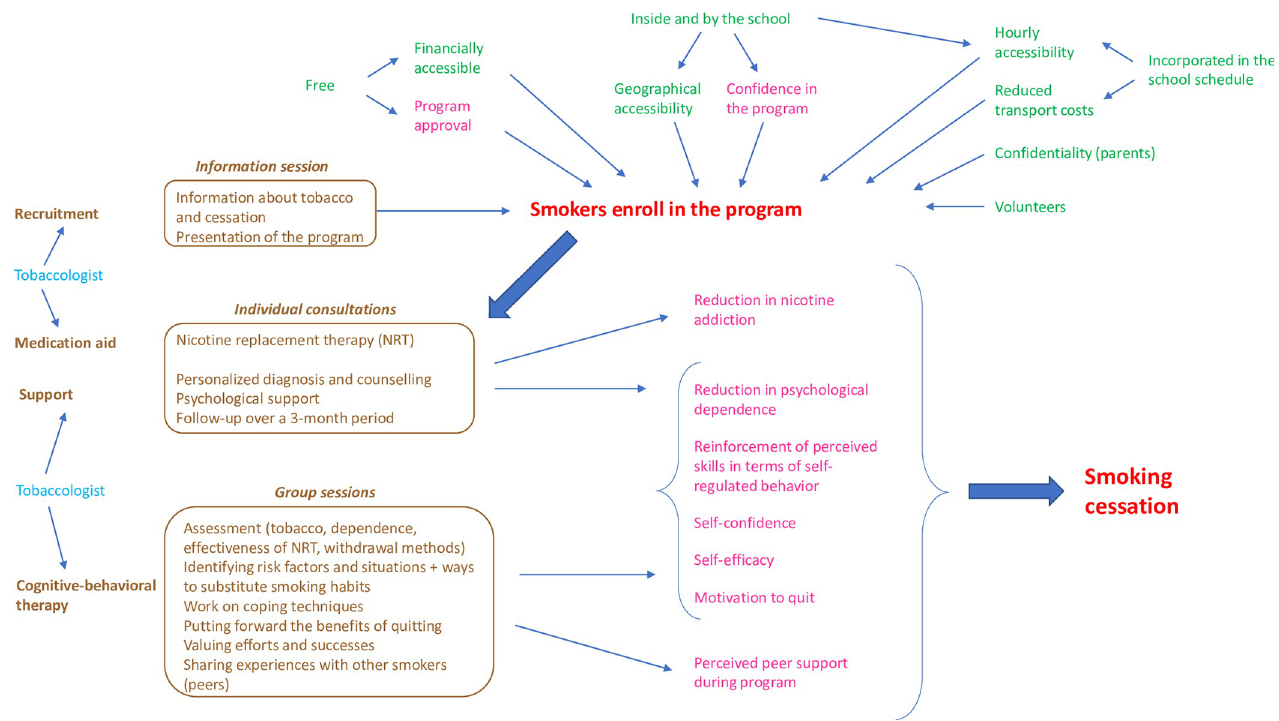
Fig 1. Initial TABADO